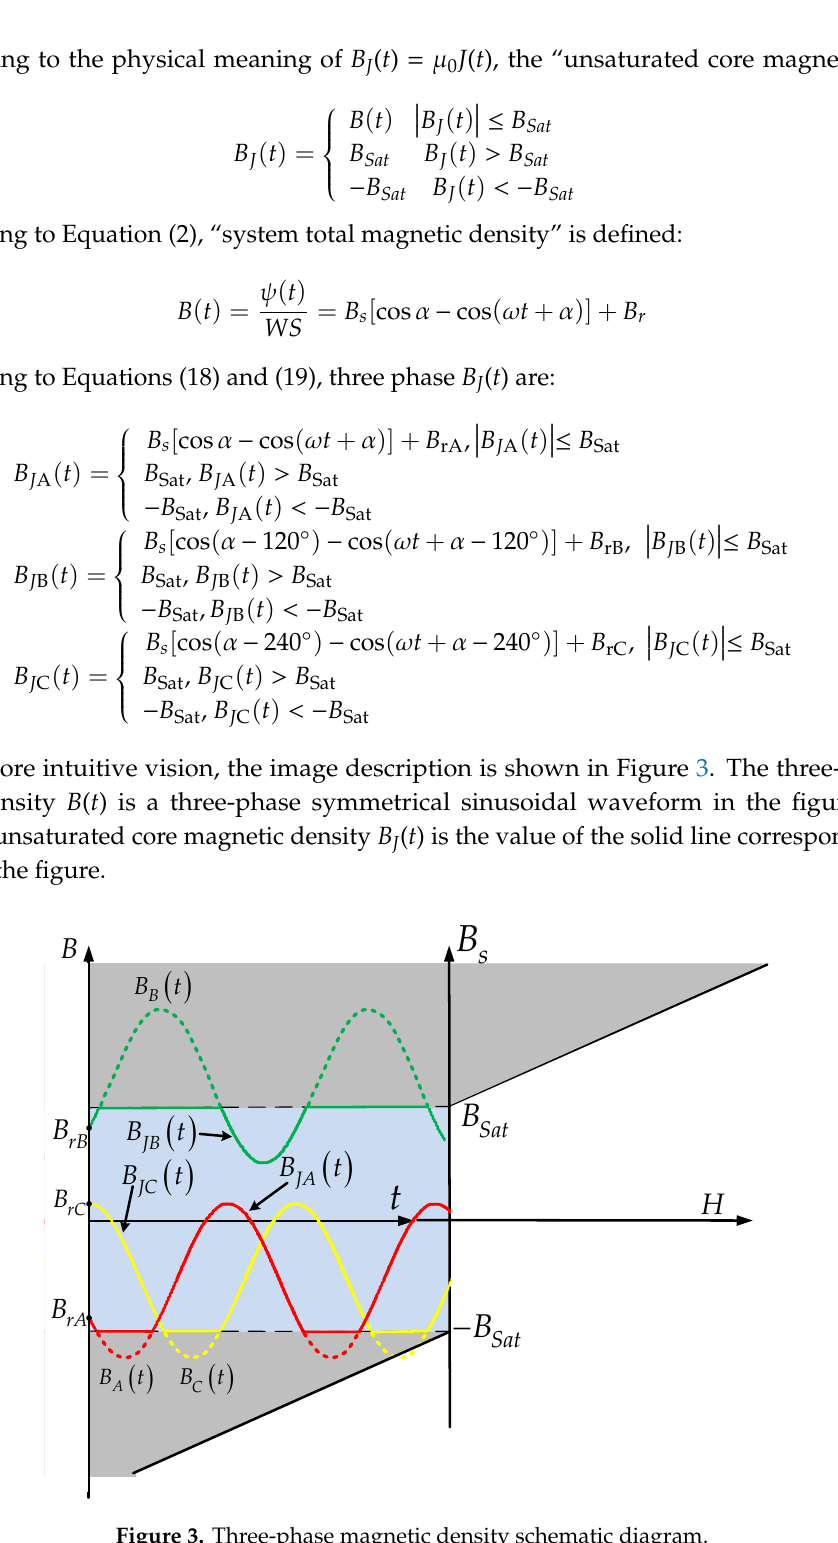
Table 1. The comparison of the three parameters. Parameters